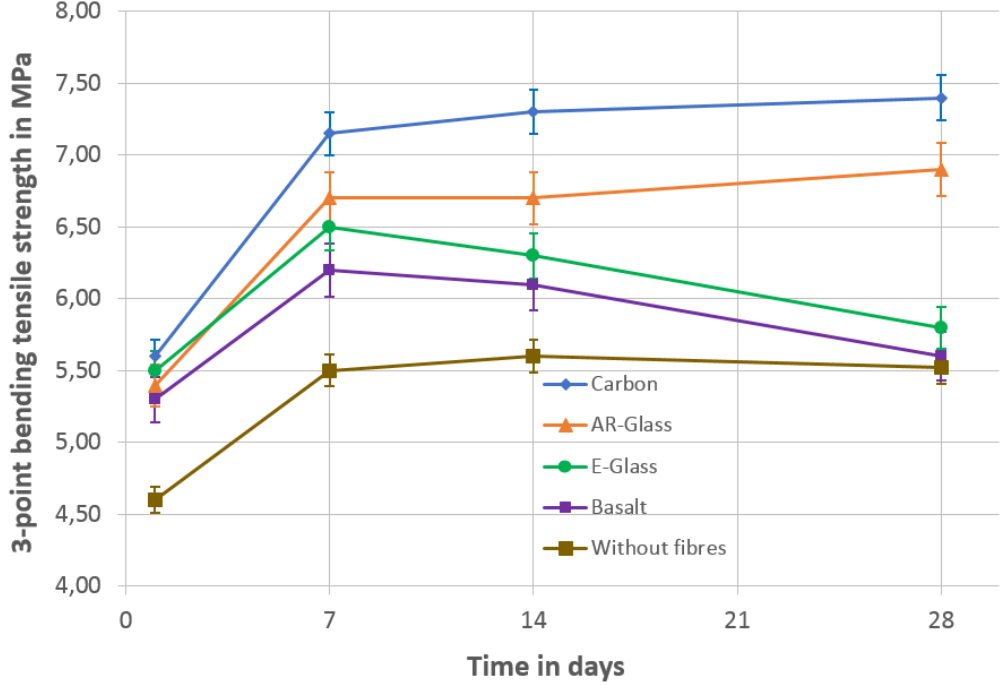
Figure 5. Performance of the fibers in the AAB-matrix as a function of